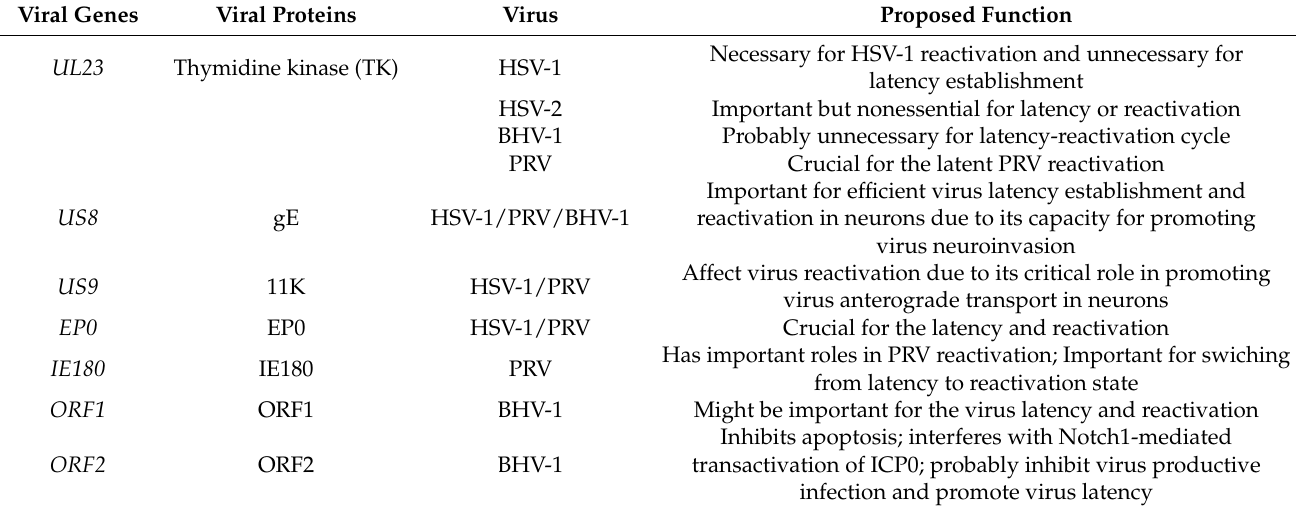
Table 1. The viral proteins participated in alphaherpesviruses latency as described in this